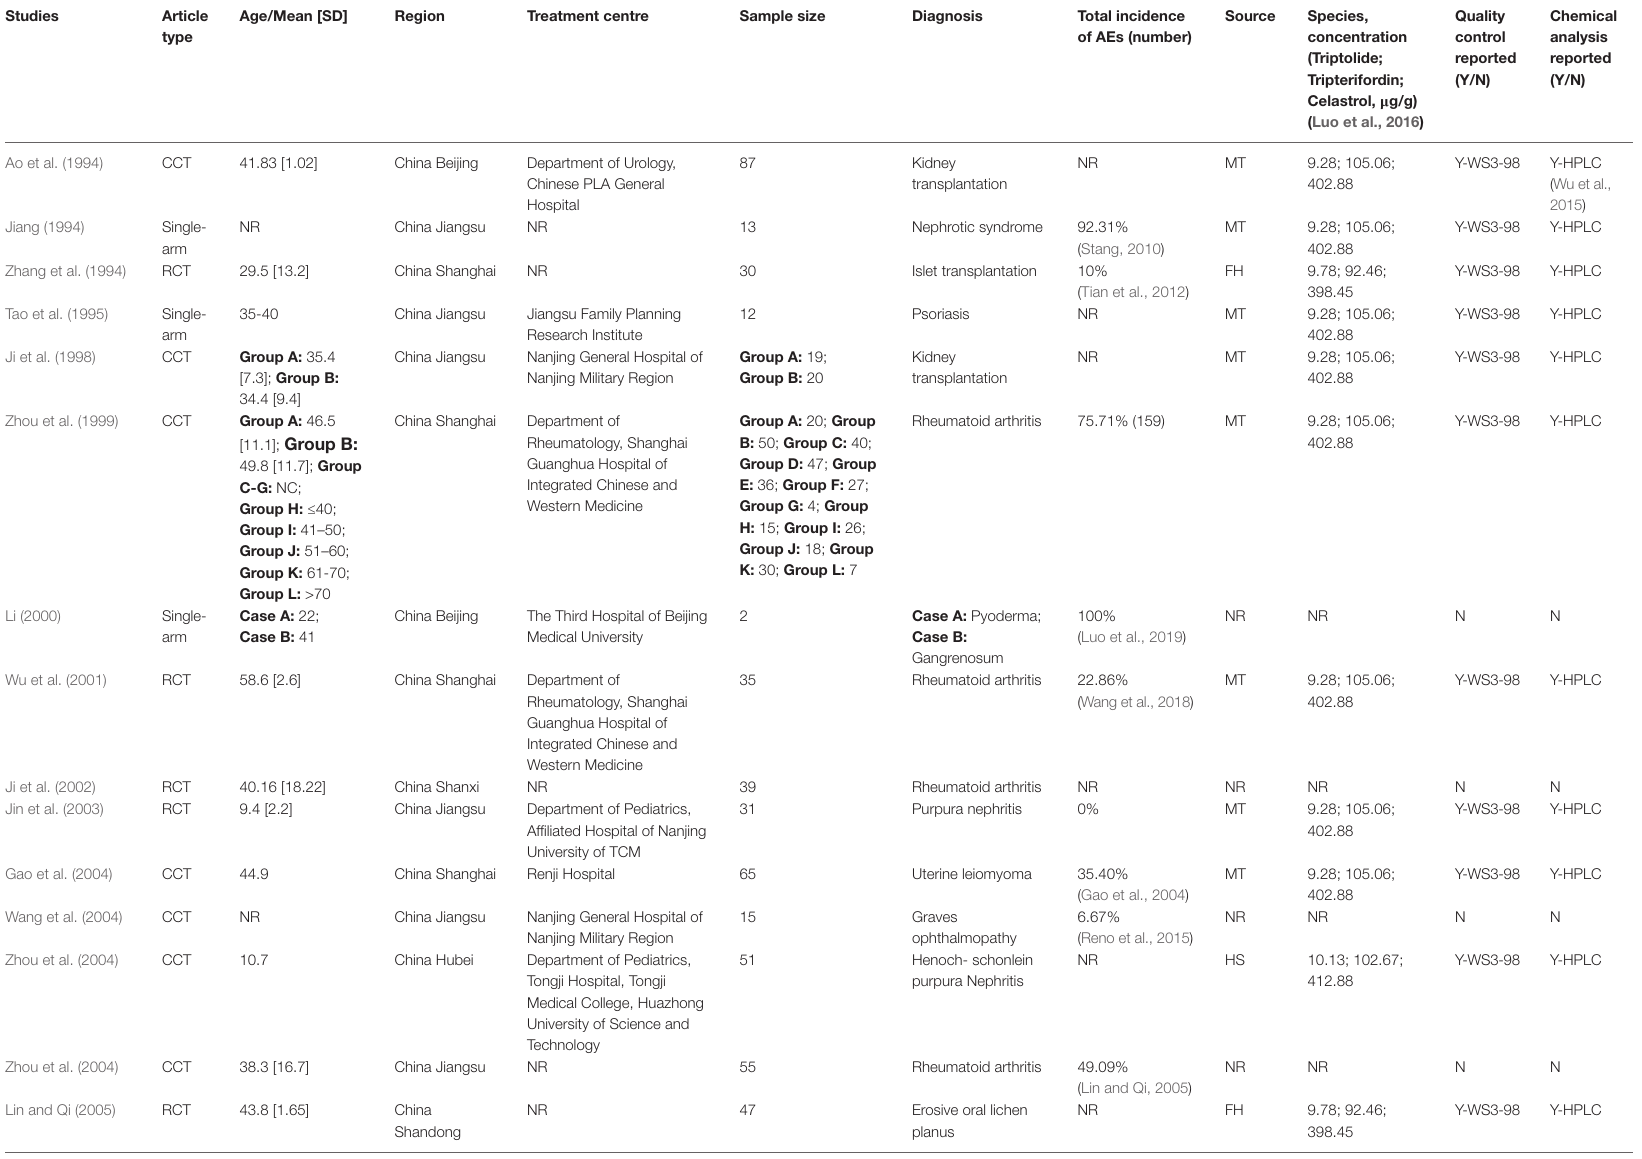
TABLE 1 | Characteristics of the included